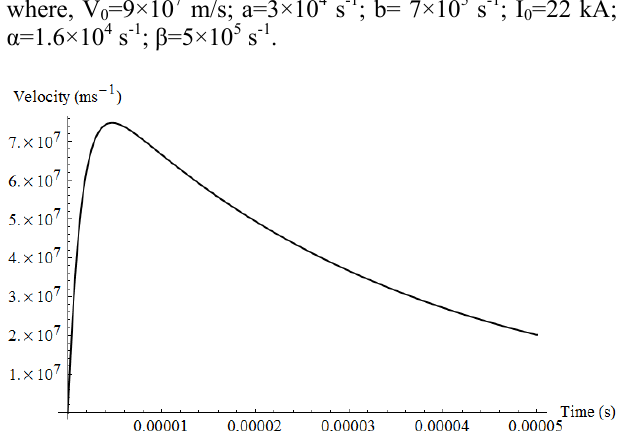
Figure 2: Velocity of RS-LC system with